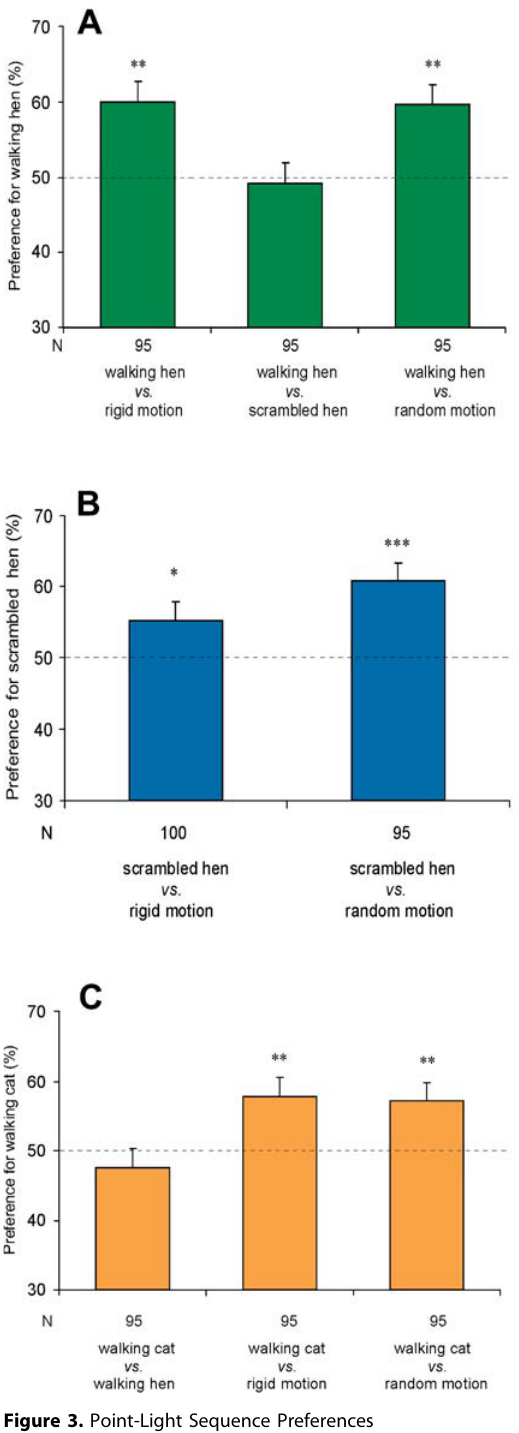
Figure 3. Point-Light Sequence Preferences (A) Preferences (group means and the standard error of the mean) estimated as the percentage of time spent close to the walking hen. (B) Preferences are shown as the percentage of time spent close to the scrambled hen. (C) Preferences are shown as the percentage of time spent close to the walking cat. Asterisks indicate significant departures from chance level (i.e., 50%) estimated by one-sample two-tailed t tests (* p , 0.05; ** p , 0.01; *** p , 0.001). DOI: 10.1371/journal.pbio.0030208.g003